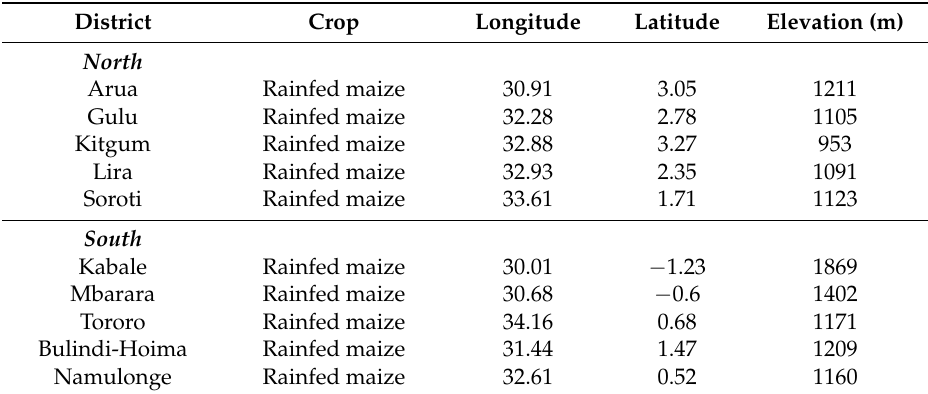
Table 1. Locational coordinates and altitude of the 10 districts under